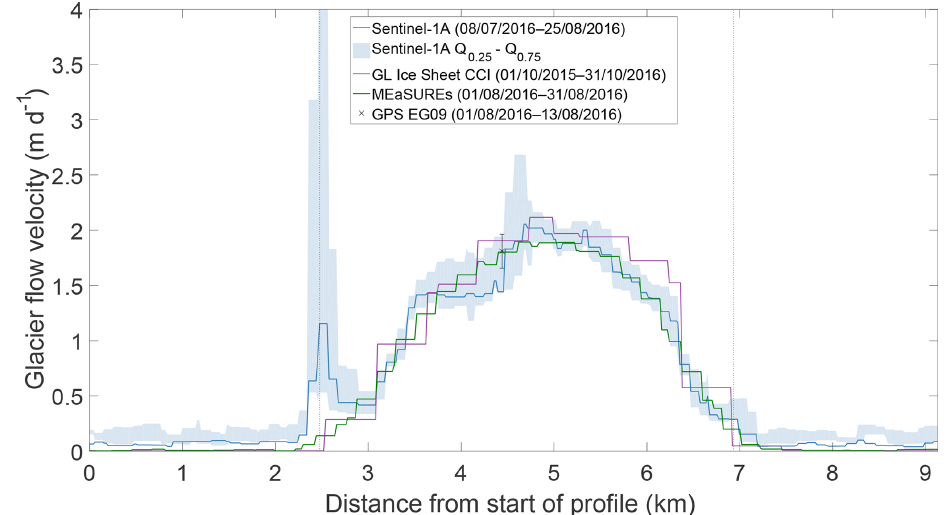
Figure A6. Mean flow speed across the position of GPS tracker EG09 (see Fig. 1) derived from S1A scenes acquired between 8 July and 25 August 2016 (48d), starting at the orographic left side of the glacier. Reference flow velocities from MEaSUREs and Greenland Ice Sheet CCI products are shown in green and purple. The dashed lines depict the glacier’s margins. Note the peak at the orographic left margin emerges from a debris covered marginal